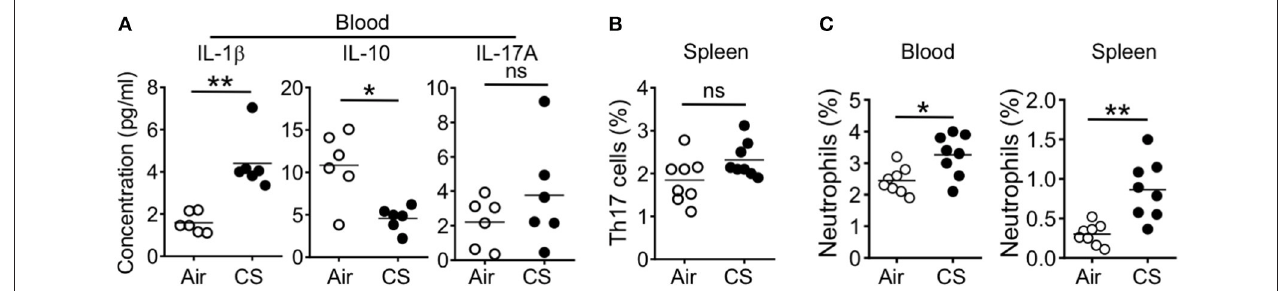
FIGURE 4 | CS exposure induce systemic pro-Th17 cell responses and neutrophilia. Mice were exposed to air or CS for 2 months. (A) Quantification of indicated cytokines in the blood as determined by Luminex assay (B) Frequencies of Th17 cells in spleen from Air and CS mice as determined by flow cytometry. (C) Frequencies of neutrophils (CD11b + Ly6G + cells) in blood and spleen from air or CS mice. Percentages of CD11b + Ly6G + neutrophils among live cells are shown. Data is representative from two independent experiments with 6–8 animals (mean ± SEM). Mann-Whitney test (A) or Student’s t -test (B,C) was used to determine significance. ns, P > 0.05; * P ≤ 0.05; ** P <